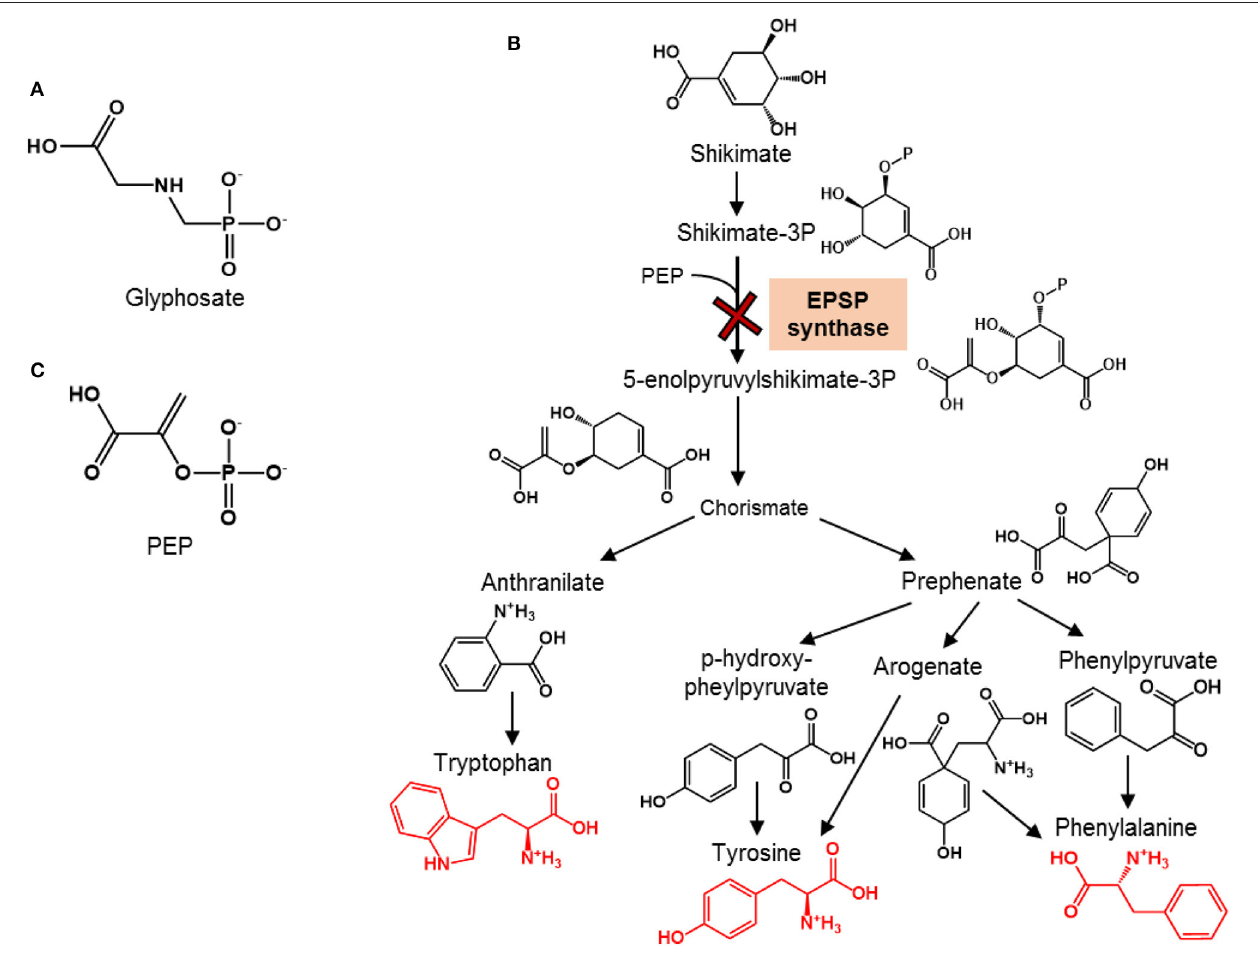
FIGURE 1 | Chemical structures of glyphosate and phosphoenolpyruvate and overview of the shikimate pathway for aromatic amino acid synthesis. (A) Chemical structure of the herbicide glyphosate. (B) Schematic of the shikimate pathway for the biosynthesis of aromatic amino acids (shown in red structures) in plants (adapted from Tzin and Galili, 2010); the toxicity target of glyphosate, which is the enzyme responsible for the synthesis of 5-enolpyruvylshikimate-3-phosphate by combining shikimate-3P and phosphoenolpyruvate (PEP), is shown with the red cross. (C) Chemical structure of PEP, the endogenous substrate at the enzymatic target of